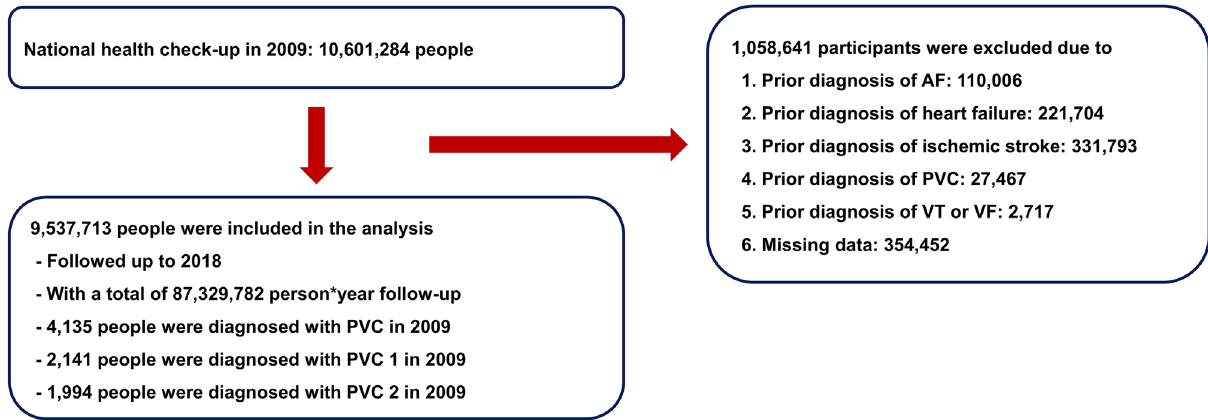
Figure 1. Study flow. AF atrial fibrillation, PVC premature ventricular contraction, VF ventricular fibrillation, VT ventricular